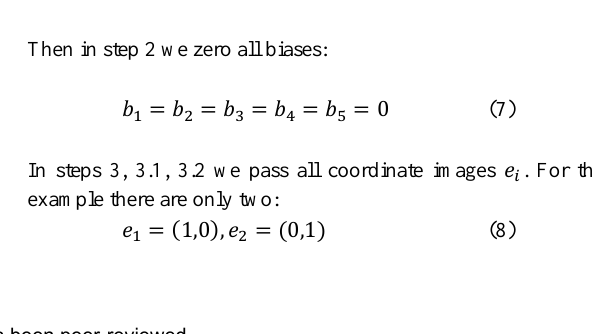
Figure 4. vector X = (X 1 , X 2 ) is passed as an input to the CNN. We marked in red connections, that are active for a current connections are